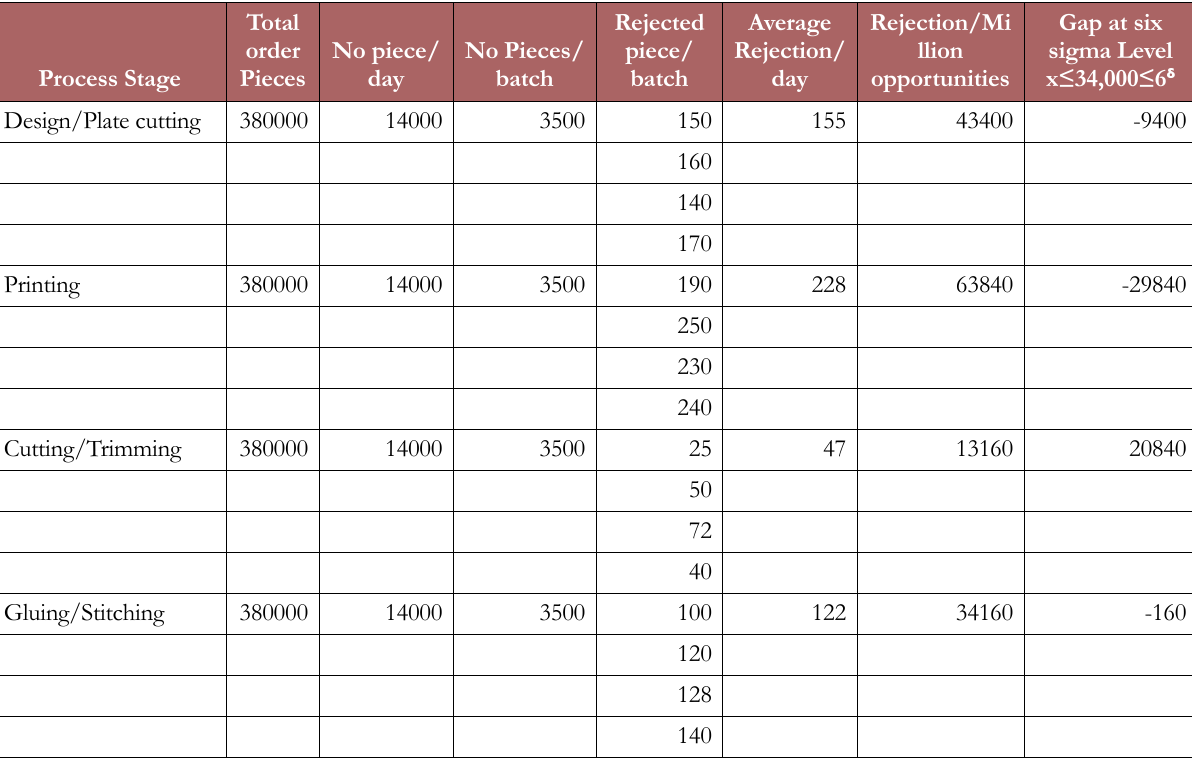
Table 4. Estimation of Non-Conforming